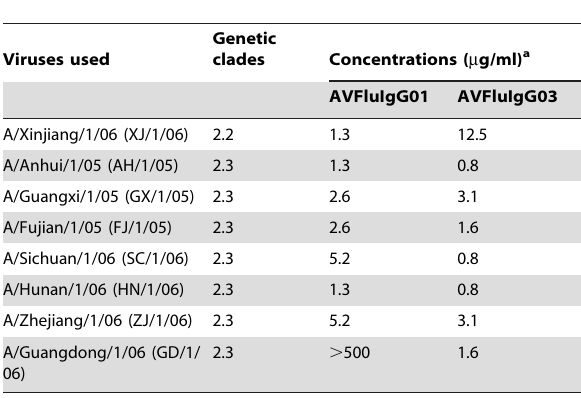
Table 2. Neutralization activity of recombinant